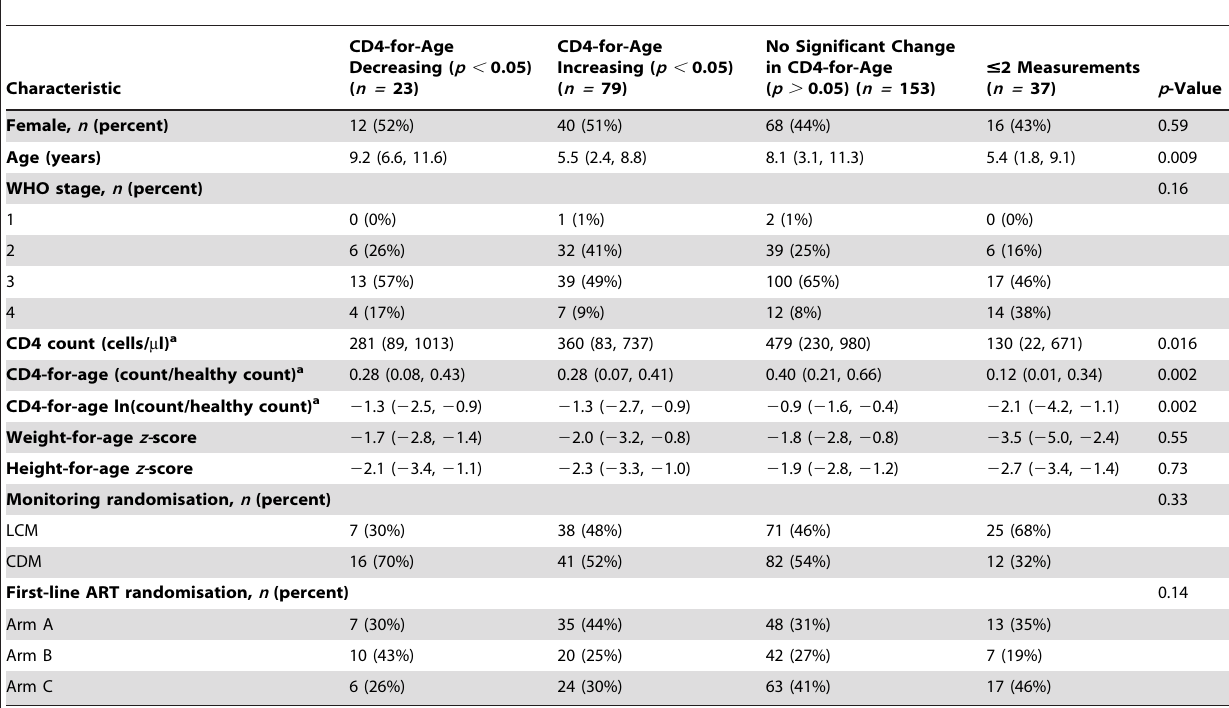
Table 3. Characteristics at ART initiation of four subgroups of HIV-infected ART-naı¨ve children who did not show asymptotic CD4- for-age reconstitution on long-term ART ( n =